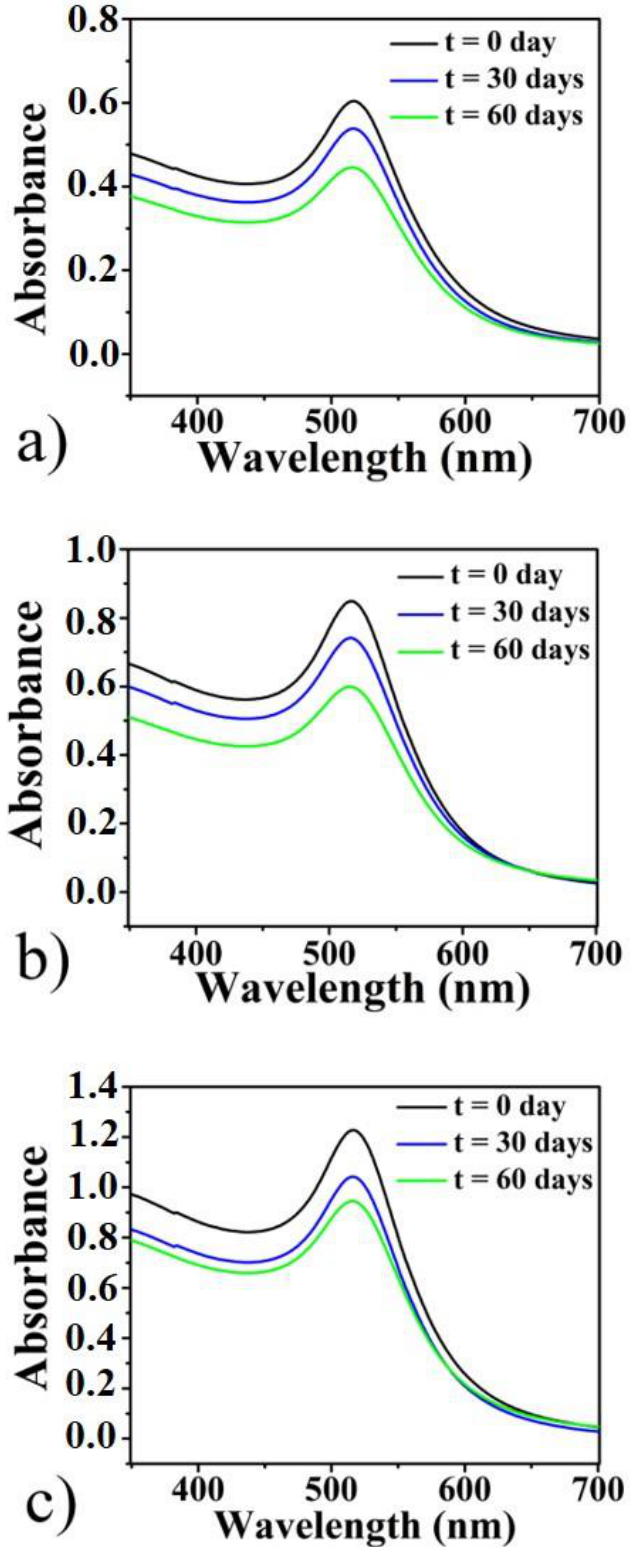
Figure 3. UV-Vis (Ultraviolet-Visible) absorbance spectra of laser synthesized Au nanocolloids immediately after the ablation process and 30 and 60 days after the production step. In particular, 5′ AuNPs ( a ), 8′ AuNPs ( b ) and 12′ AuNPs ( c ).